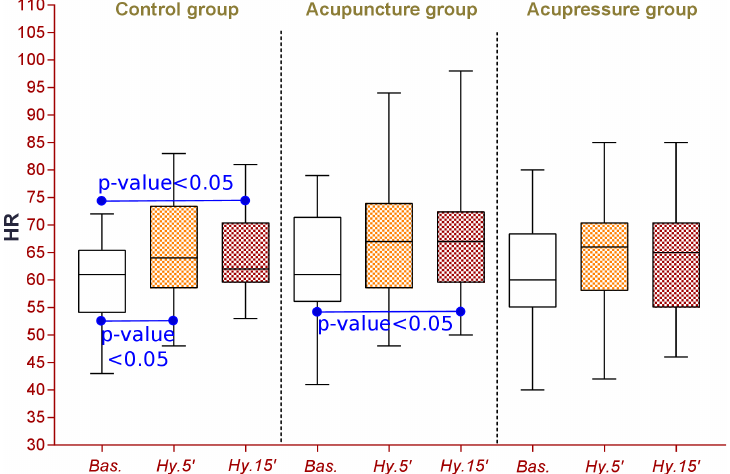
Figure 9. Descriptive analysis for heart rate (HR) beats for minute in control, acupuncture, and band (acupressure) groups at baseline and after 5 and 15 min of hypoxia.